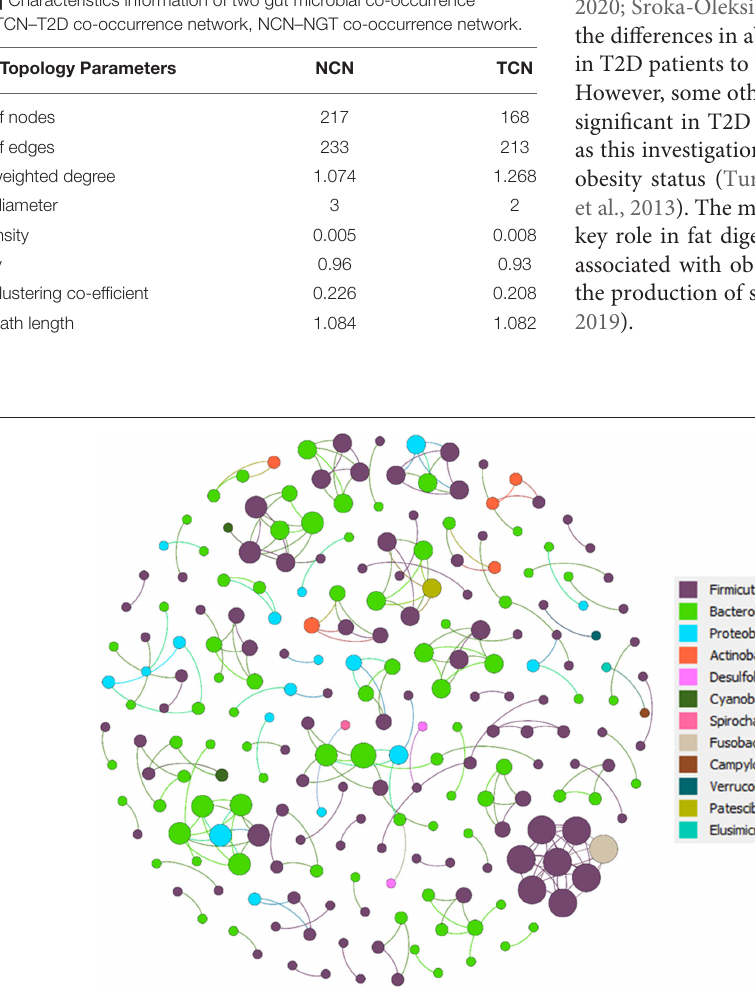
FIGURE 6 | NGT co-occurrence network (NCN). From total OTU abundance data, we select the NGT specific OTUs using the specified criteria, and a co-occurrence microbial network was constructed in Gephi.